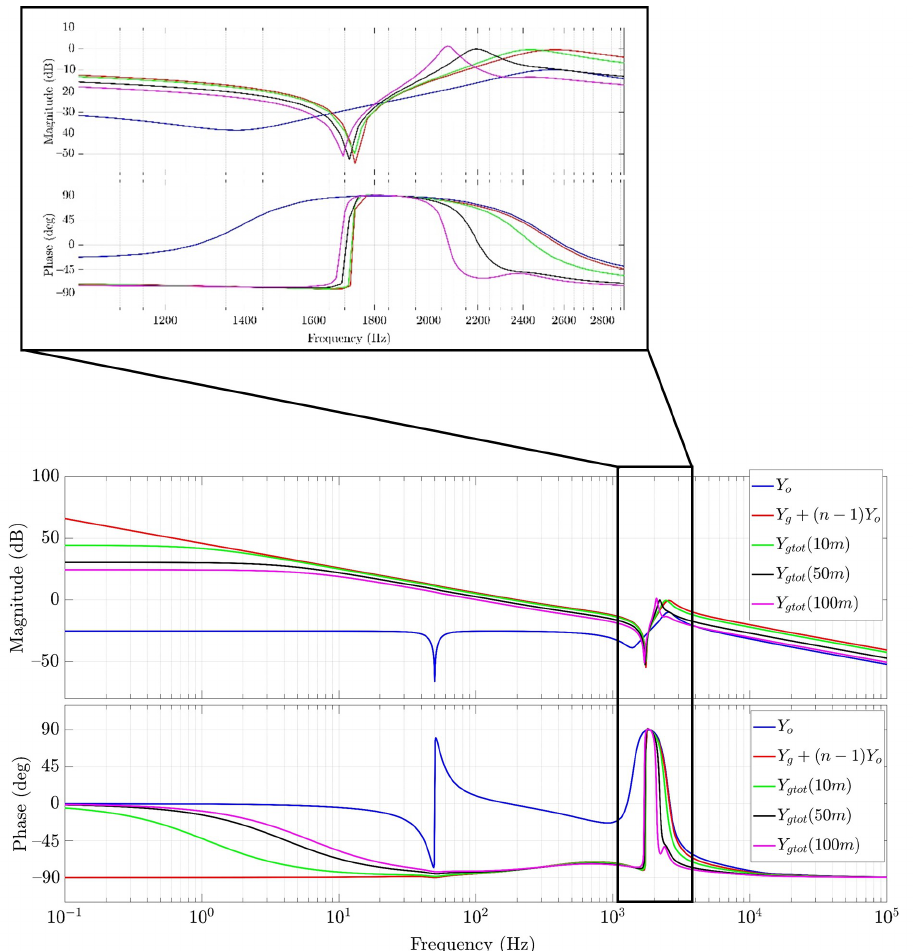
Figure 19. Bode plot of output admittance of inverter 1 and the admittance of the equivalent grid with the additional impedances between the connection